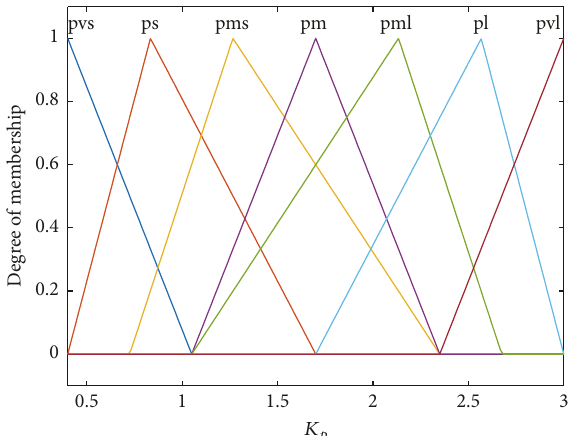
Figure 6: Membership functions designed for the output 𝑘 𝑝 .